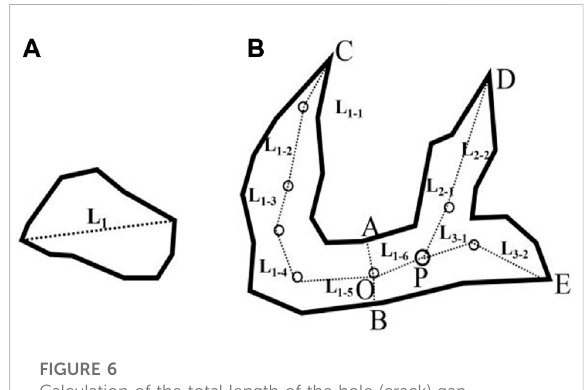
Calculation of the total length of the hole (crack)